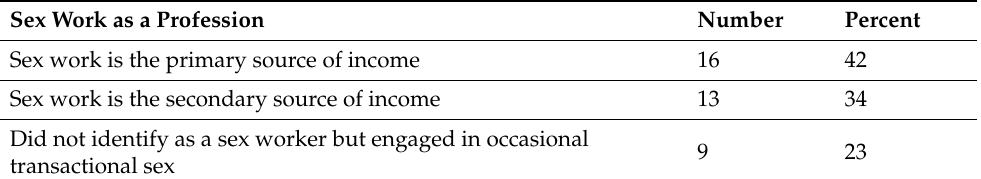
Table 3. Identification as a commercial sex